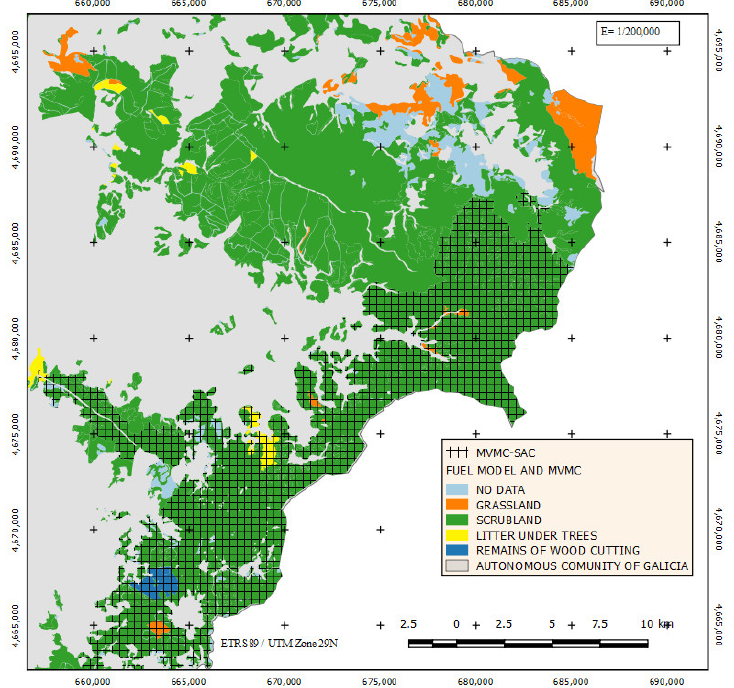
Figure 7. The image shows the intersection of the MVMC-SAC (with a squared pattern) and MVMC no SAC with the Spanish forest map (MFE), allowing for the evaluation of existing fuel models in each of them as well as any differences.